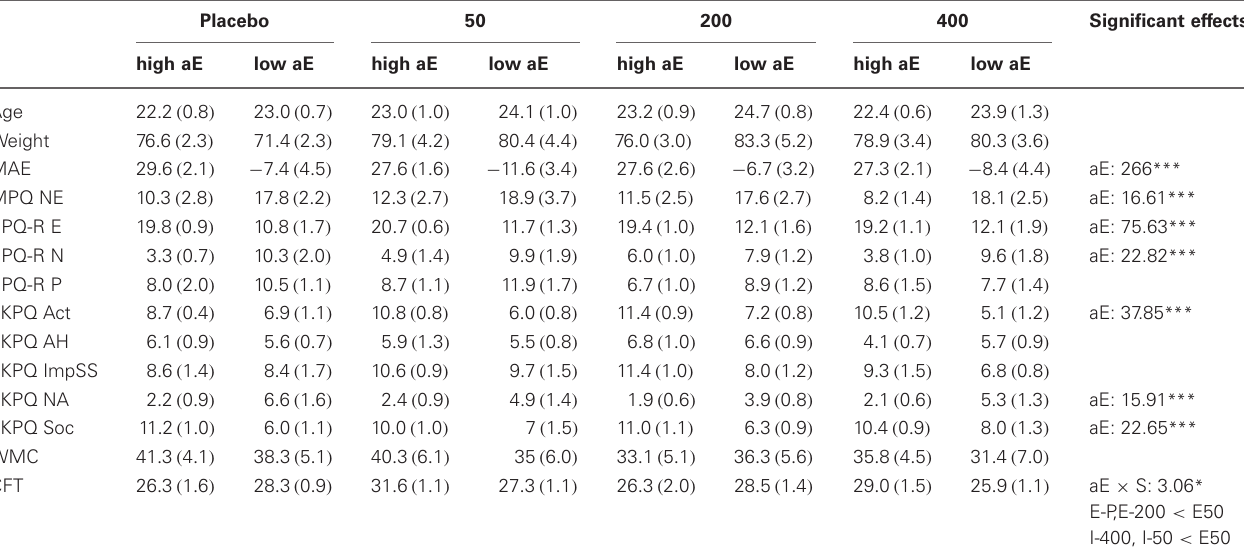
Table 1 | Sample characteristics and descriptive statistics.